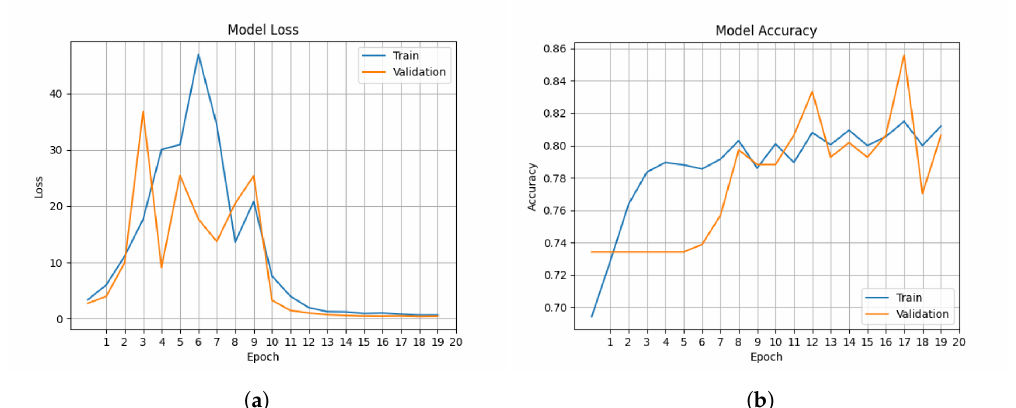
Figure 14. Curves of ( a ) average loss and ( b ) average accuracy during the model training for fruit quality